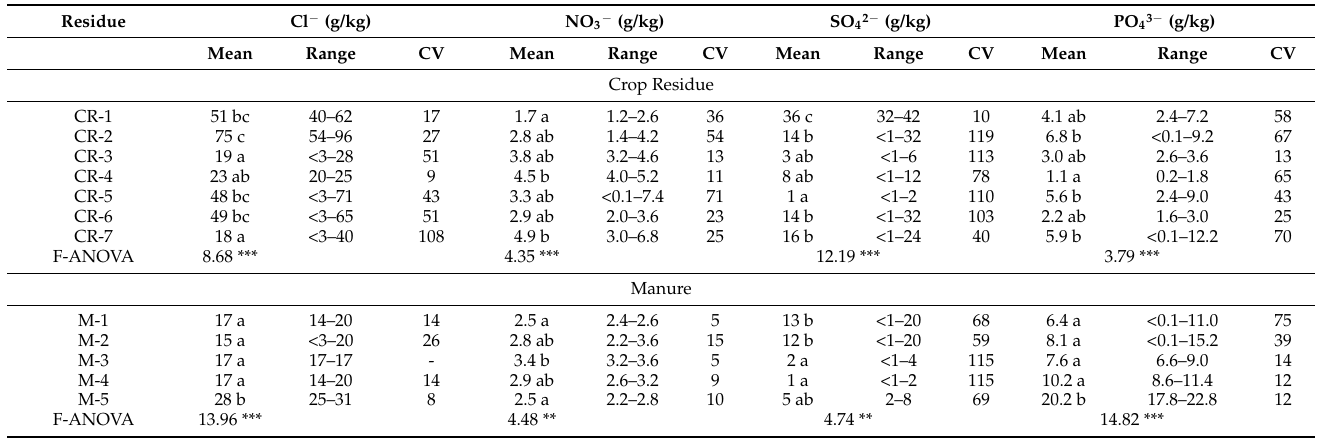
Table 3. Soluble anion contents (on a dry weight basis) of the agro-livestock